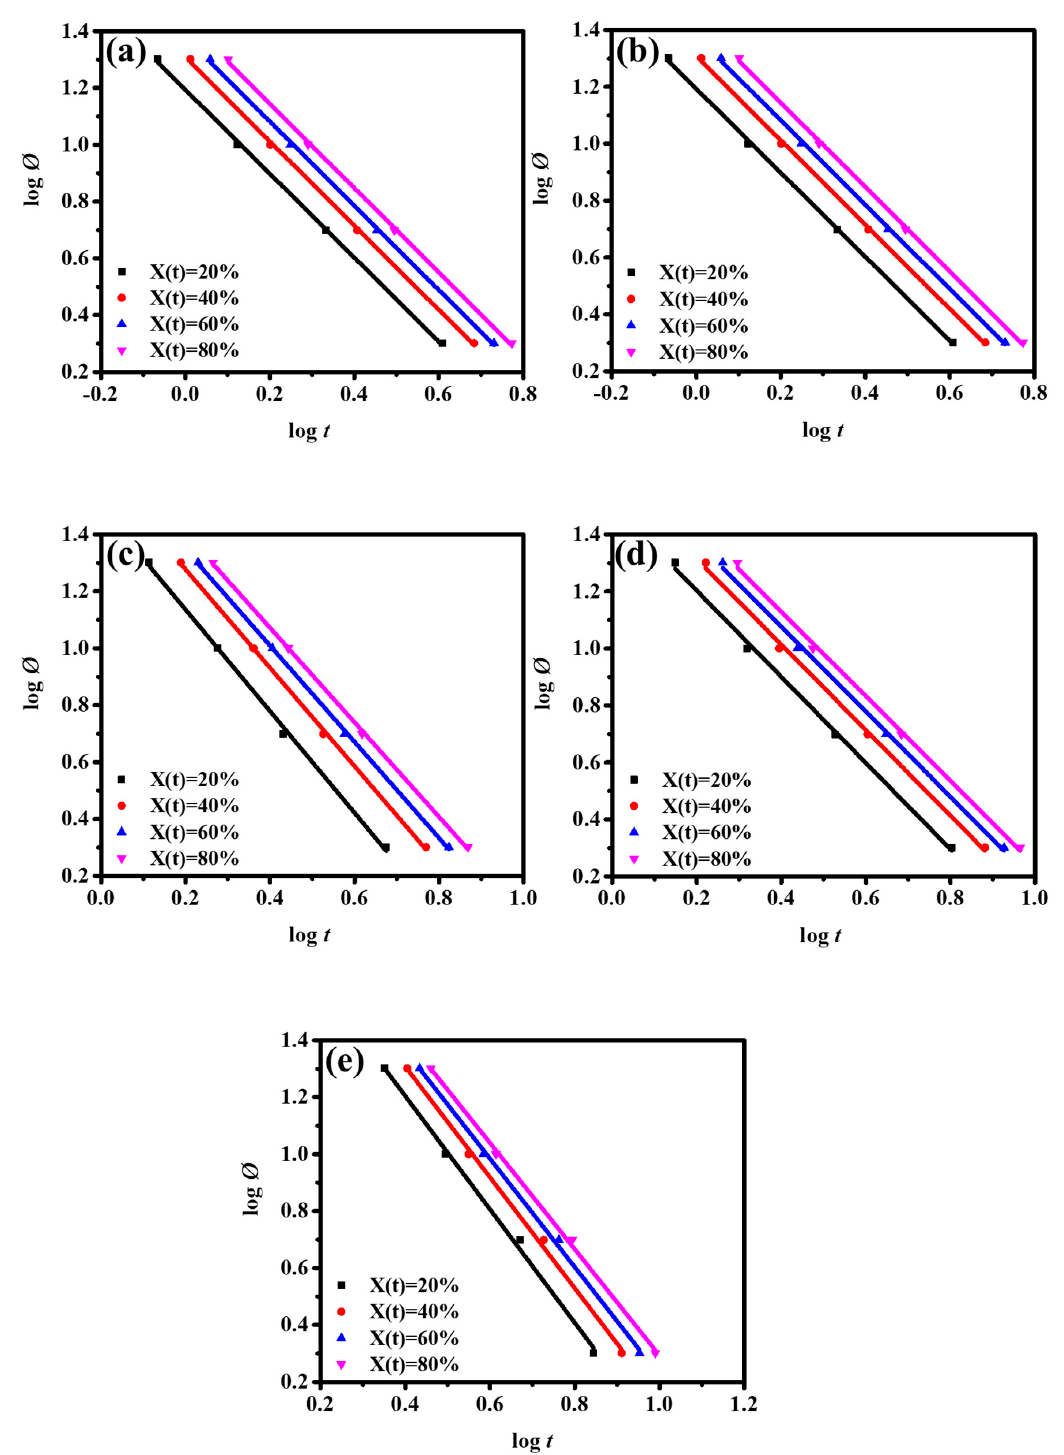
Figure 9. Curves of log ∅ versus log t for PBT- co -PTMEG copolymers: ( a ) PBT, ( b ) PBT- co -PTMEG-10,